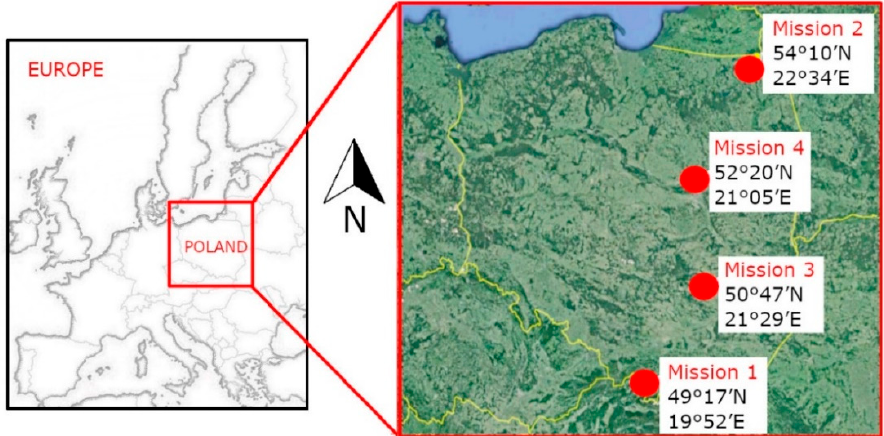
Figure 2. UAV photogrammetric missions for this study (Poland).